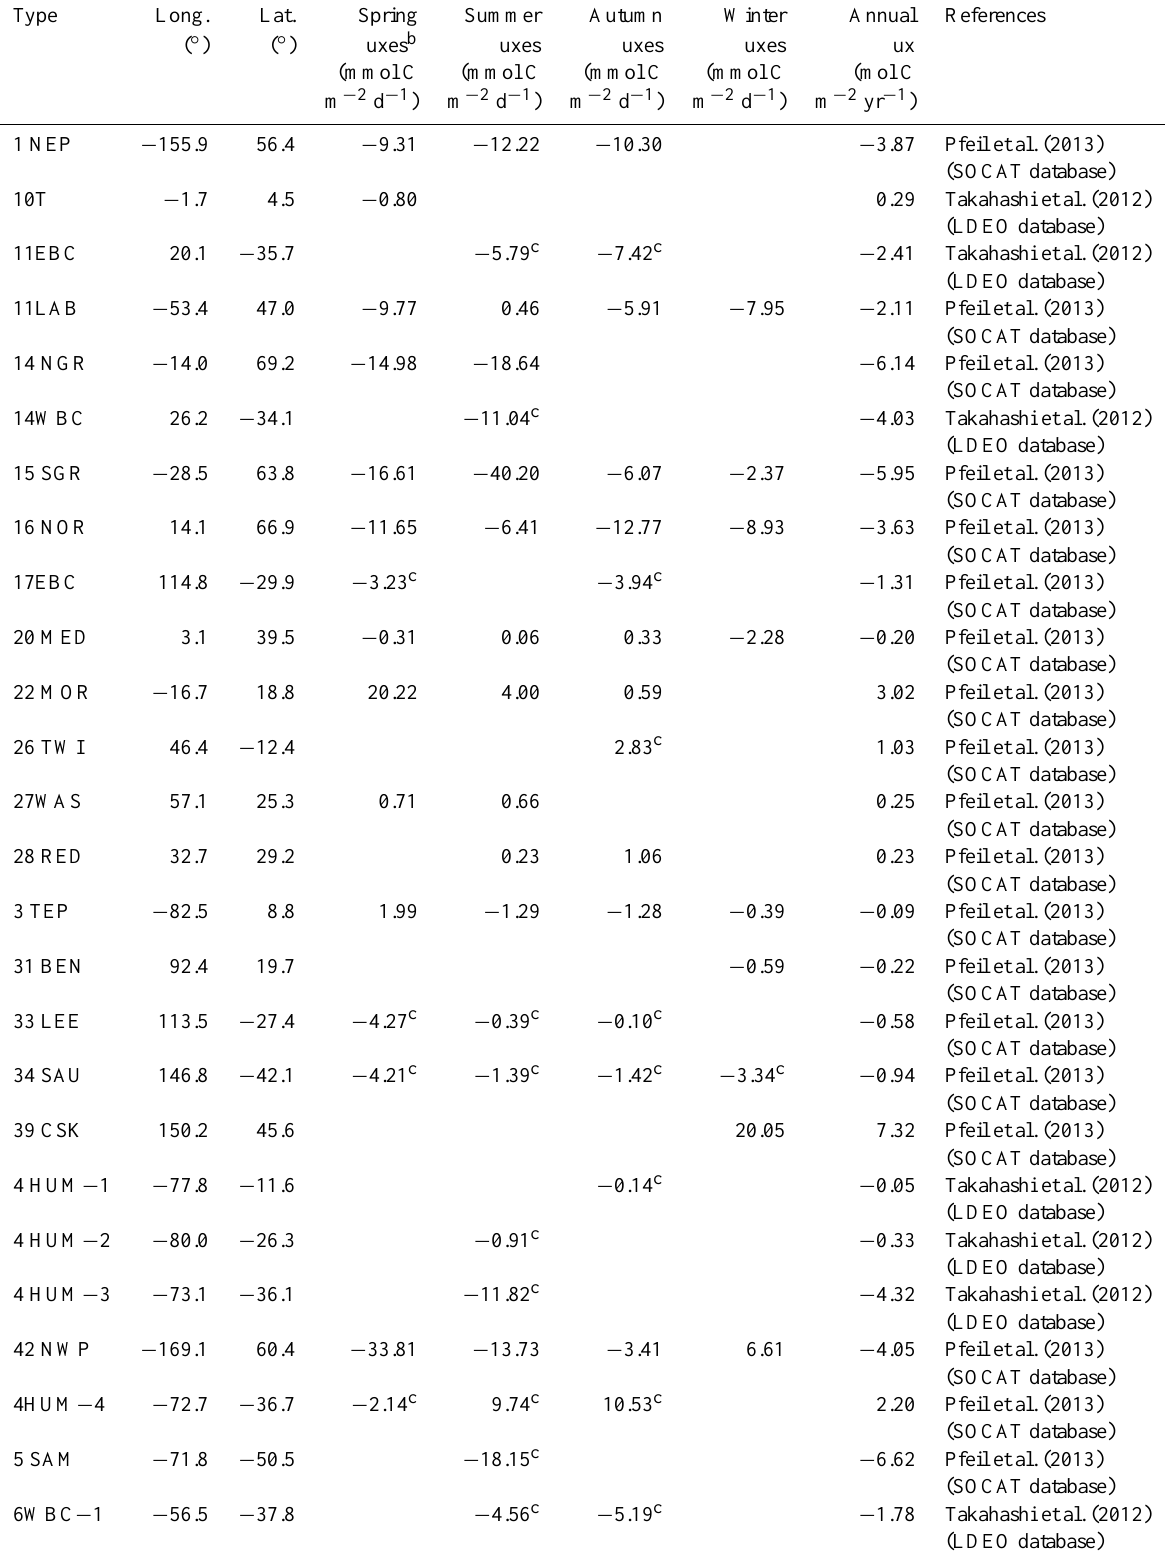
Table 5. Seasonal and annual air–sea fluxes of CO 2 in the world’s continental shelves. Type Long.